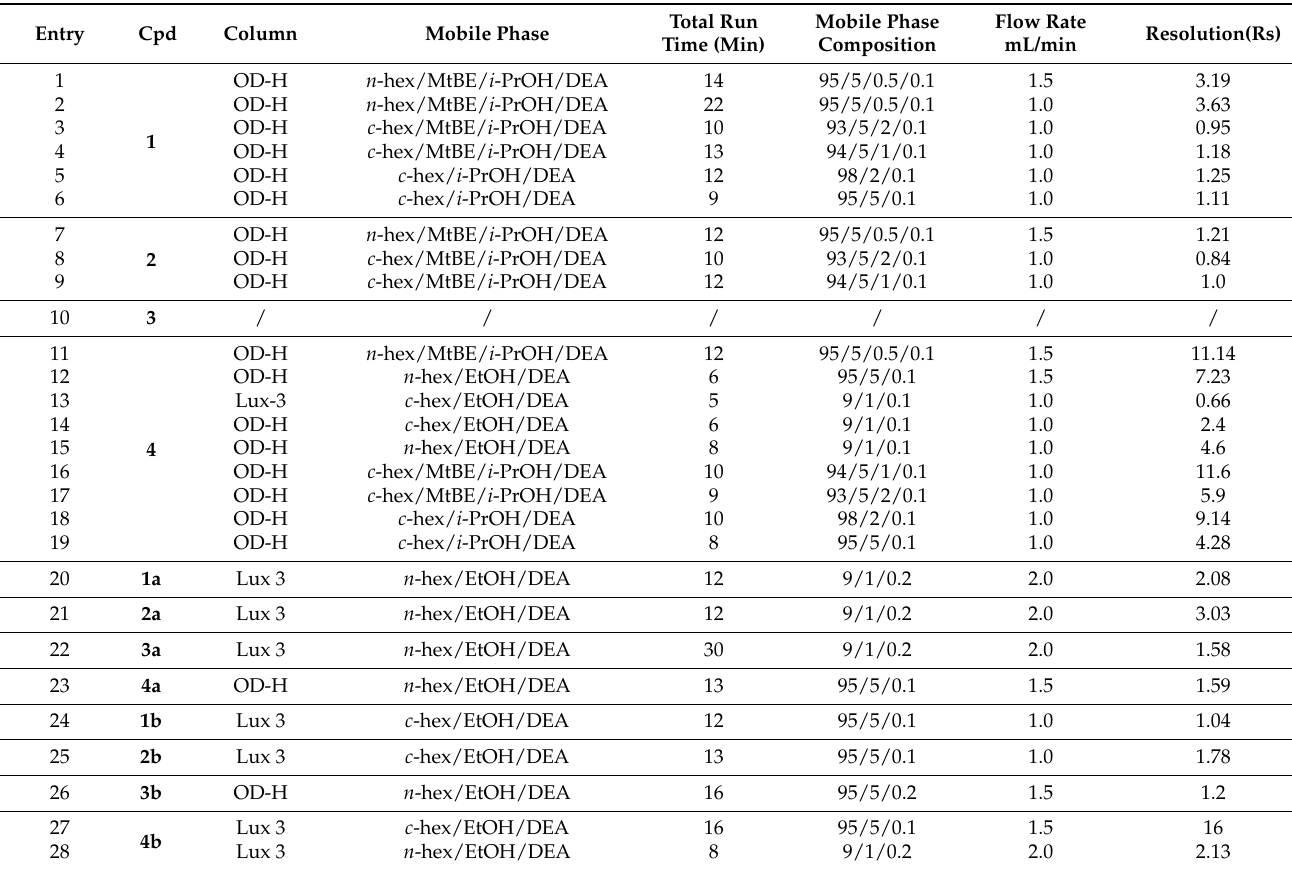
Table 1. Chromatographic separation data for amines 1 – 4 , and amides 1a – 4a and 1b – 4b